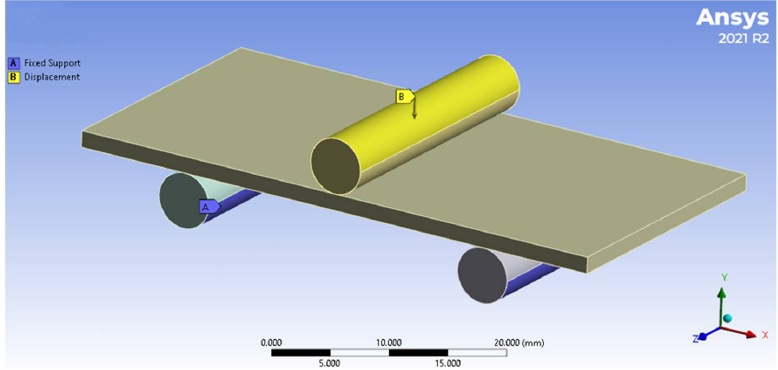
Figure 3. The model’s contact boundary conditions .